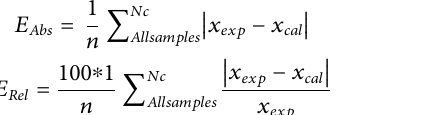
Frontiers in Chemistry |